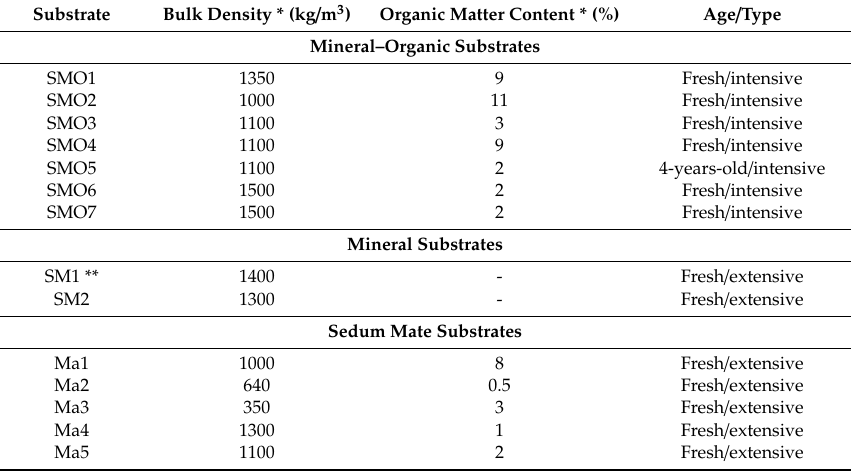
Table 1. Characteristic of green roof substrates analyzed in the